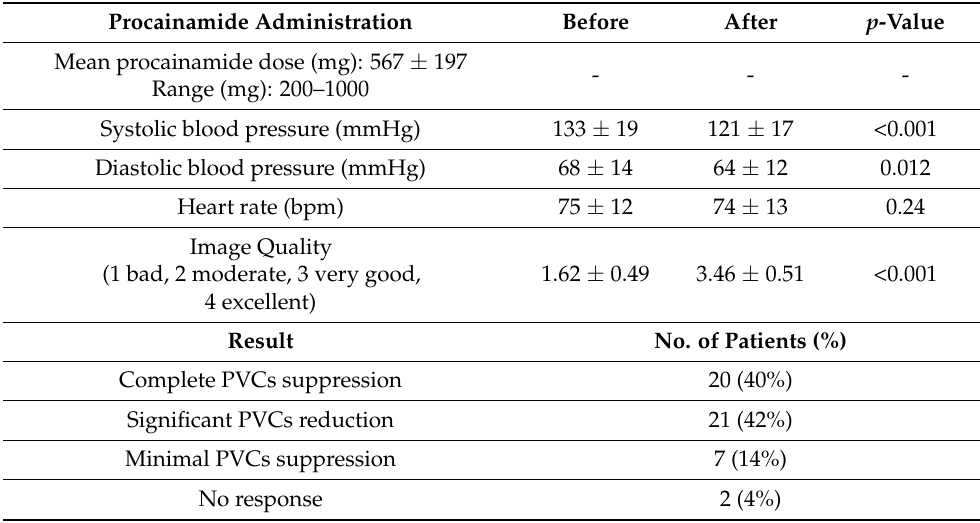
Table 2. Procainamide dose and effect on hemodynamic parameters and arrhythmia burden. Procainamide Administration Before After p -Value Mean procainamide dose (mg): 567 ±